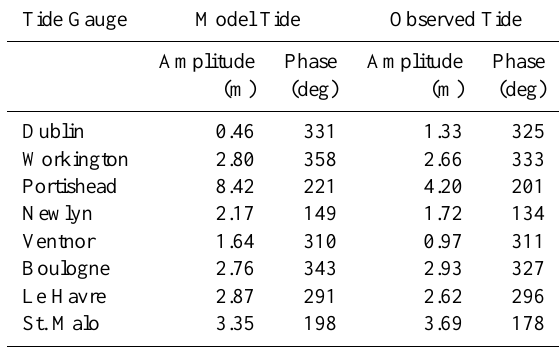
Table 2. Amplitude and phase of K1 tide calculated by the model compared with observations at representative tide